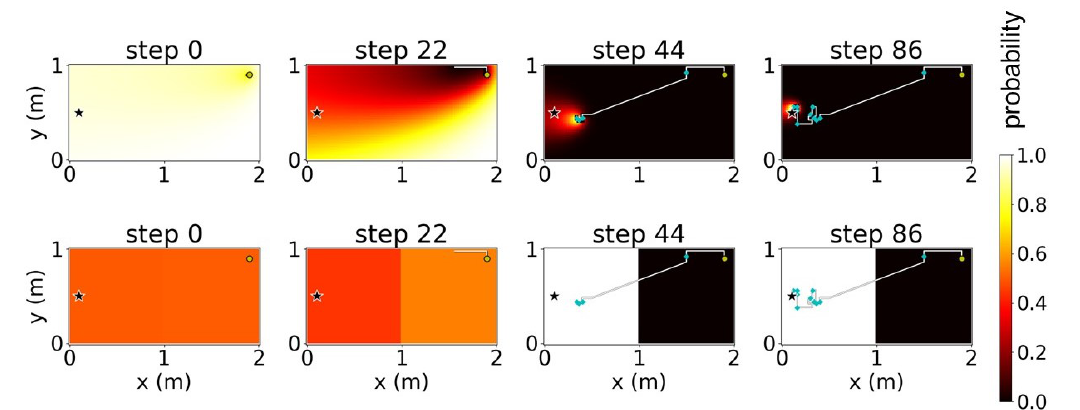
Figure 8. Timeline of a search using environment decomposition with the number of sub- environments ( K ) = 2 and stand-out coefficient ( ρ ) = 1. The star indicates odor source